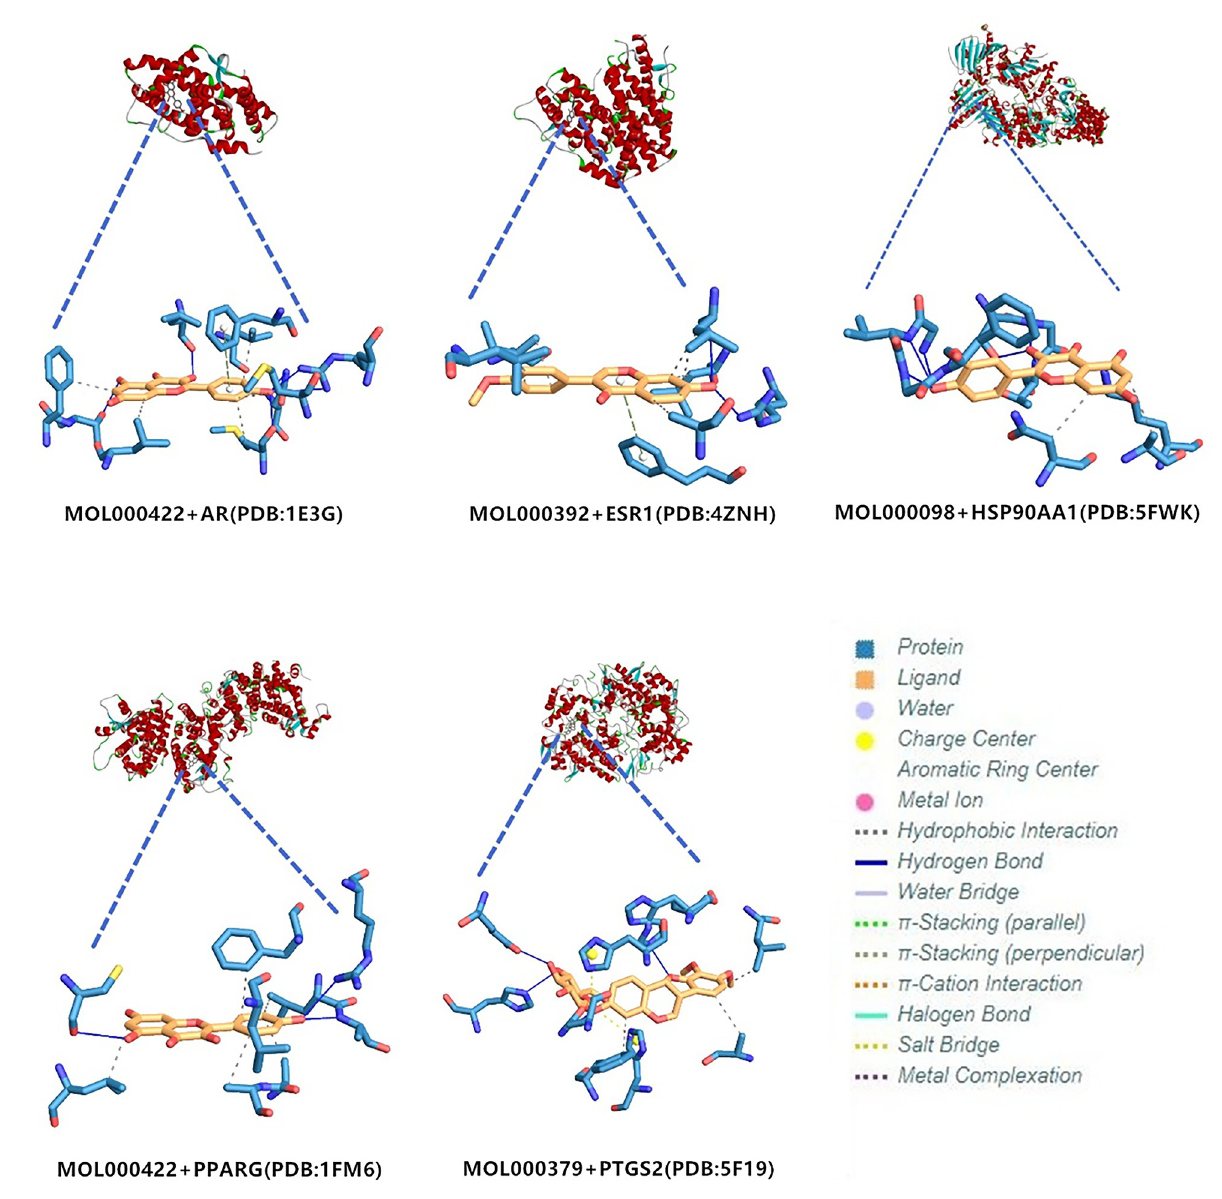
Fig 10. Core targets molecular docking. Core targets molecular docking. The meaning of colors and graphics can be known from the legend.